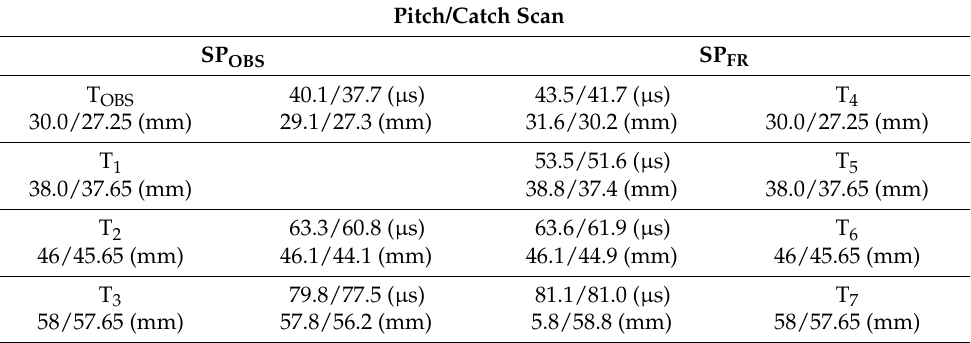
Table 2. Details of the original observations (raw data) and SAFT-processed data for the pitch/catch mode scan (Figure 4). Numbers shown below the targets (T OBS and T N ) are the depths of the centers and the tops of the relative holes (center/top). Numbers above the slash of relative imaged echoes show the information of original observations and those below the slash are obtained from the results of the SAFT